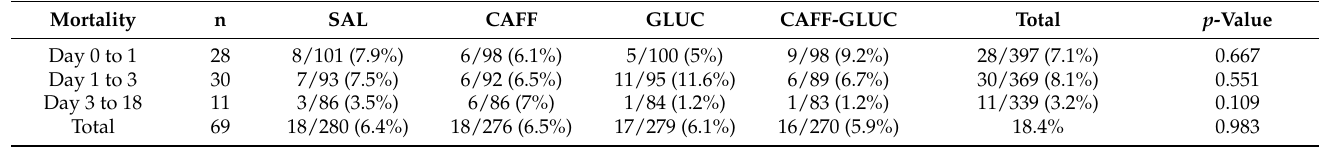
Table 3. Mortality at day 1, 3, and 18 of piglets allocated to oral treatments at birth; saline (SAL), caffeine (CAFF), glucose (GLUC) and caffeine plus glucose